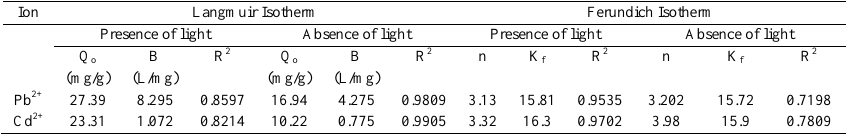
Table 7. Langmuir and Freundlich isotherm constants for the adsorption of lead (II) and cadmium